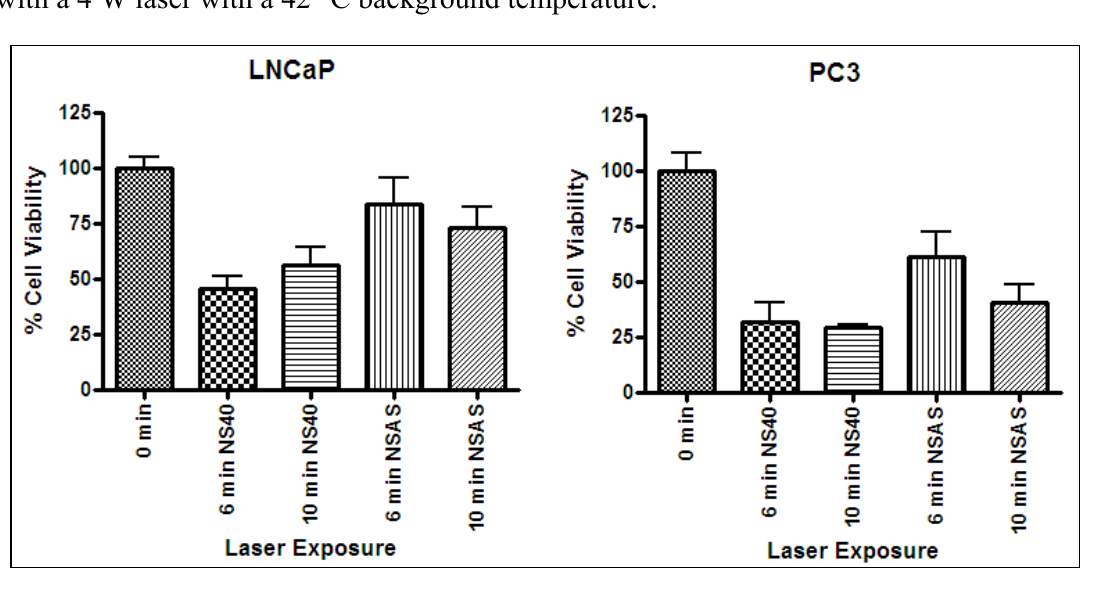
Table 1. Summary of the decrease in cell viability and changes in temperature